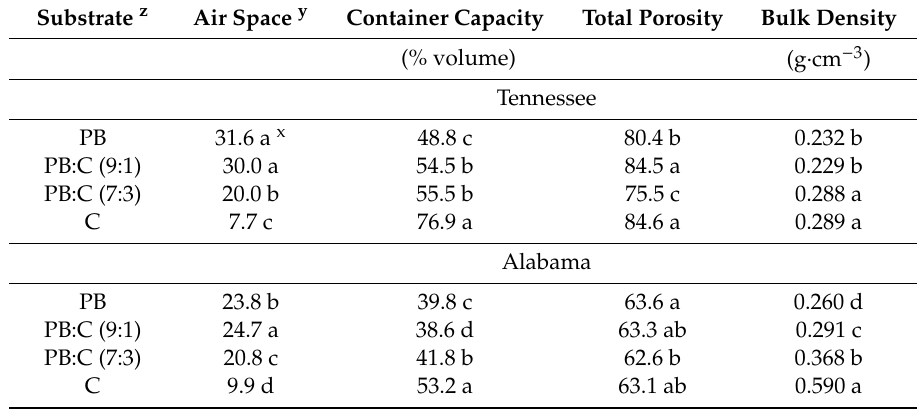
Table 1. Physical properties ( n = 3) of substrate components and substrates for production of “Green Giant” arborvitae in Tennessee (McMinnville) and Alabama (Mobile). Substrate z Air Space y Container Capacity Total Porosity Bulk Density (% volume) (g · cm − 3 )